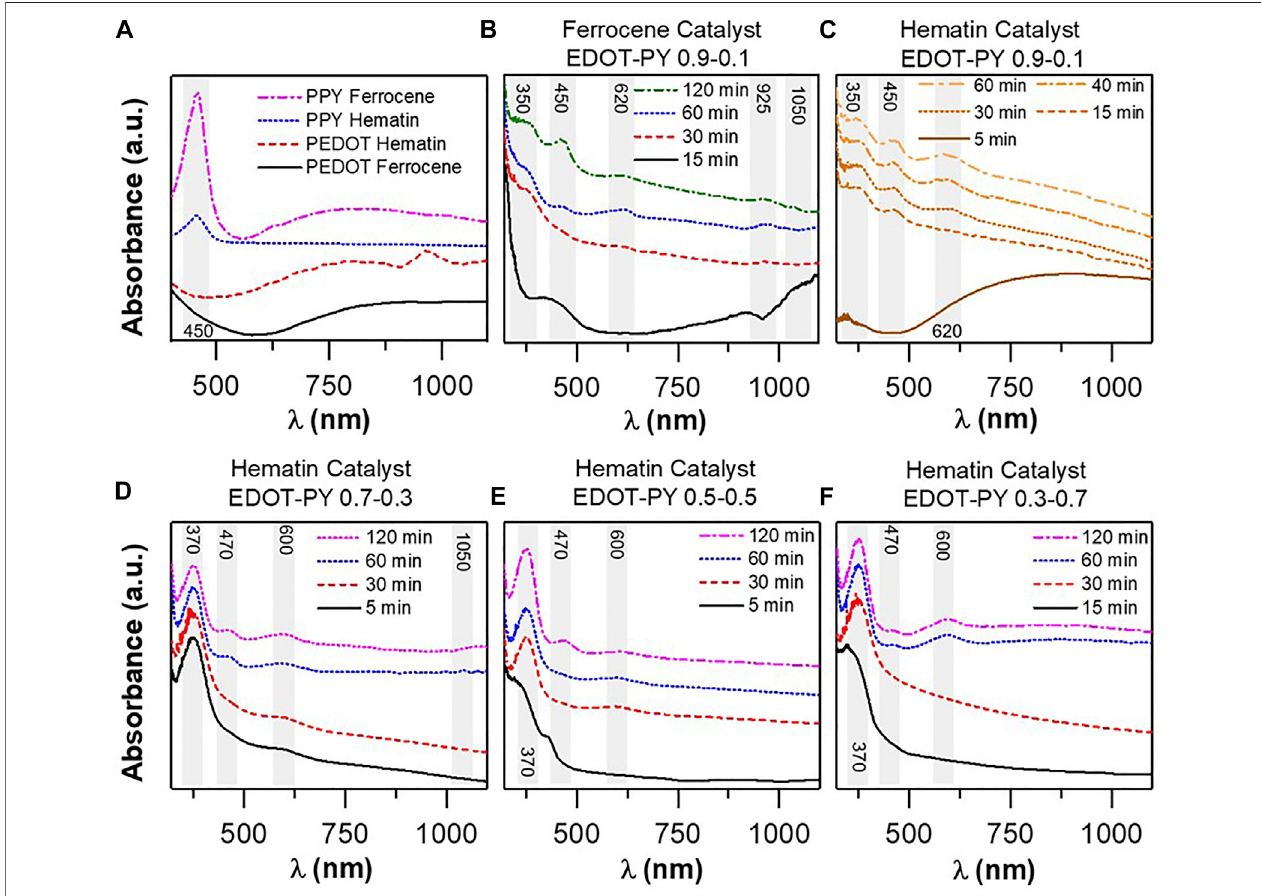
FIGURE 1 | (A) UV-vis spectra of biomimetically synthesized PEDOT and PPY homopolymers in the presence of different catalysts, (B) UV-vis monitoring of the polymerizationoftheEDOT-PY0.9 – 0.1copolymer(Xmolar)catalyzedinthepresenceofFerrocene, (C) UV-vismonitoringofthepolymerizationoftheEDOT-PY0.9 – 0.1 copolymer (X molar) catalyzed in the presence of Hematin, (D) UV-vis monitoring of the polymerization of the EDOT-PY copolymer 0.7 – 0.3 Hematin, (E) UV-vis monitoring of EDOT-PY copolymer polymerization 0.5 – 0.5 Hematin, (F) UV-vis monitoring of EDOT-PY copolymer polymerization 0.3 – 0.7 Hematin.